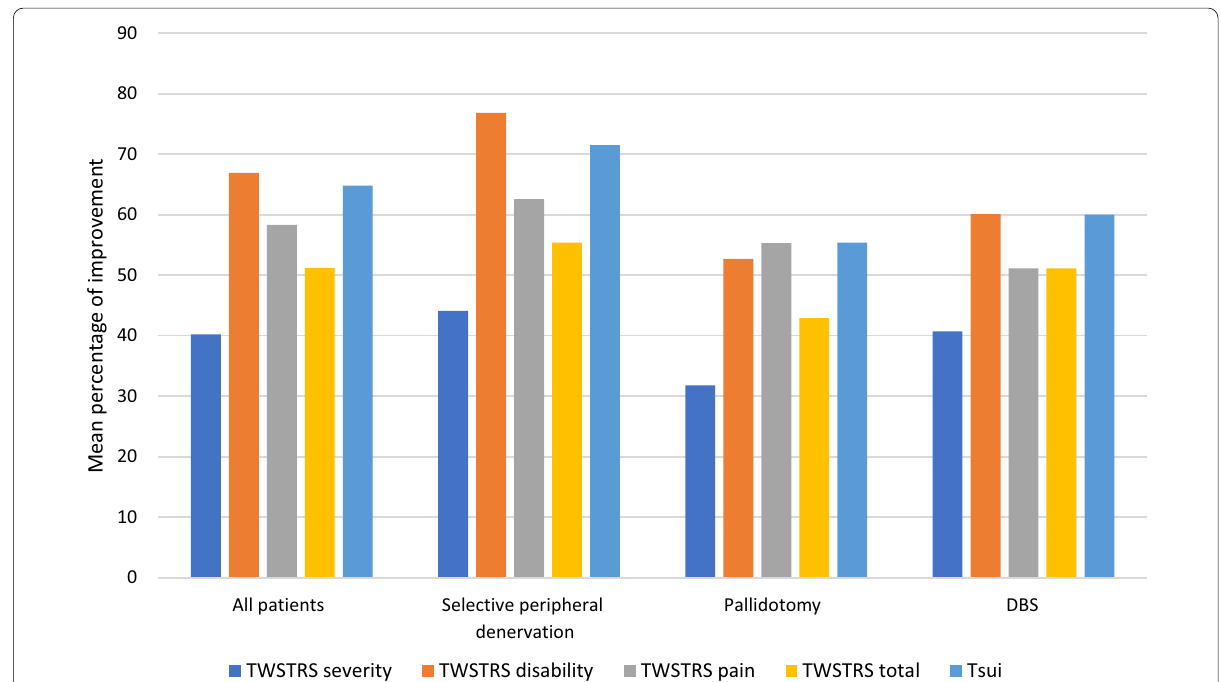
Fig. 3 Mean percentage of improvement in TWSTRS severity, disability, pain, and total score, and Tsui score among our all-study population, patients who underwent selective peripheral denervation, pallidotomy, and